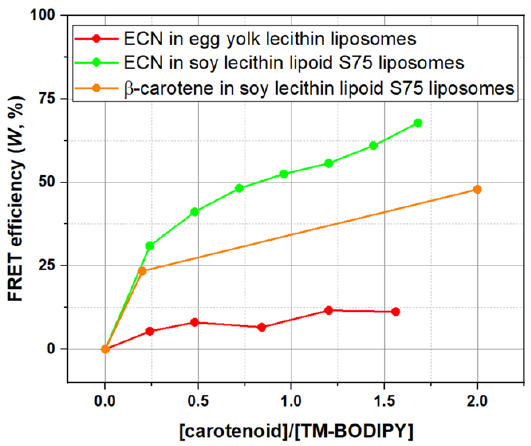
Figure 7. Dependence of FRET efficiency between carotenoids (echinenone (ECN) or β -carotene) and TM-BODIPY on the molar concentration ratio between them, measured in liposomes with different phospholipid composition.